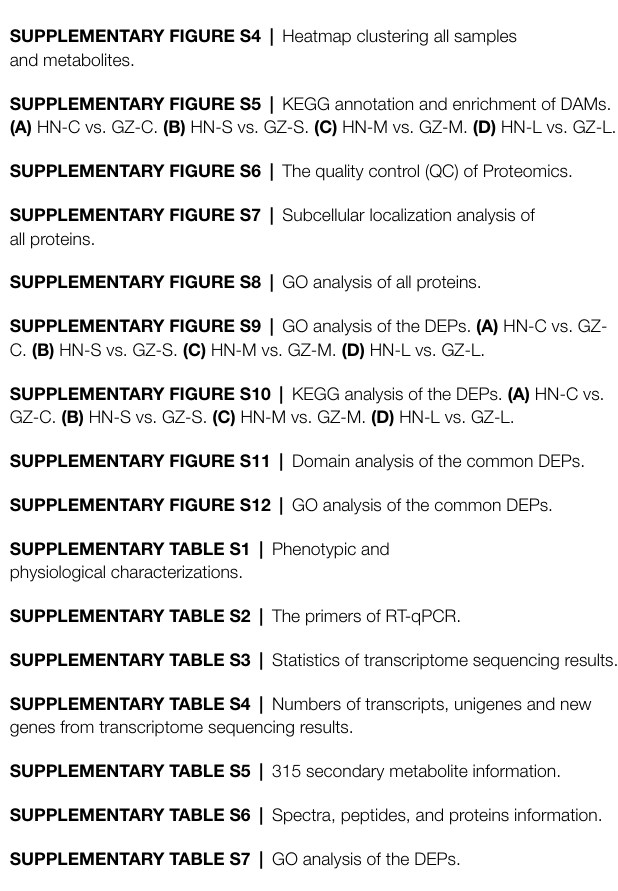
SUPPLEMENTARY FIGURE S1 | KEGG annotation and enrichment of DEGs. SUPPLEMENTARY FIGURE S2 | Total ions current overlaps of the three quality control samples by mass spectrometry detection. (A) TIC overlay plot in positive ionization mode. (B) TIC overlay plot in negative ionization mode. SUPPLEMENTARY FIGURE S3 | Correlation analysis for all samples and metabolites. SUPPLEMENTARY FIGURE S4 | Heatmap clustering all samples and metabolites. SUPPLEMENTARY FIGURE S5 | KEGG annotation and enrichment of DAMs. (A) HN-C vs. GZ-C. (B) HN-S vs. GZ-S. (C) HN-M vs. GZ-M. (D) HN-L vs. GZ-L. SUPPLEMENTARY FIGURE S6 | The quality control (QC) of Proteomics. SUPPLEMENTARY FIGURE S7 | Subcellular localization analysis of all proteins. SUPPLEMENTARY FIGURE S8 | GO analysis of all proteins. SUPPLEMENTARY FIGURE S9 | GO analysis of the DEPs. (A) HN-C vs. GZ- C. (B) HN-S vs. GZ-S. (C) HN-M vs. GZ-M. (D) HN-L vs. GZ-L. SUPPLEMENTARY FIGURE S10 | KEGG analysis of the DEPs. (A) HN-C vs. GZ-C. (B) HN-S vs. GZ-S. (C) HN-M vs. GZ-M. (D) HN-L vs. GZ-L. SUPPLEMENTARY FIGURE S11 | Domain analysis of the common DEPs. SUPPLEMENTARY FIGURE S12 | GO analysis of the common DEPs. SUPPLEMENTARY TABLE S1 | Phenotypic and physiological characterizations. SUPPLEMENTARY TABLE S2 | The primers of RT-qPCR. SUPPLEMENTARY TABLE S3 | Statistics of transcriptome sequencing results. SUPPLEMENTARY TABLE S4 | Numbers of transcripts, unigenes and new genes from transcriptome sequencing results. SUPPLEMENTARY TABLE S5 | 315 secondary metabolite information. SUPPLEMENTARY TABLE S6 | Spectra, peptides, and proteins information. SUPPLEMENTARY TABLE S7 | GO analysis of the DEPs. SUPPLEMENTARY TABLE S8 | KEGG analysis of the